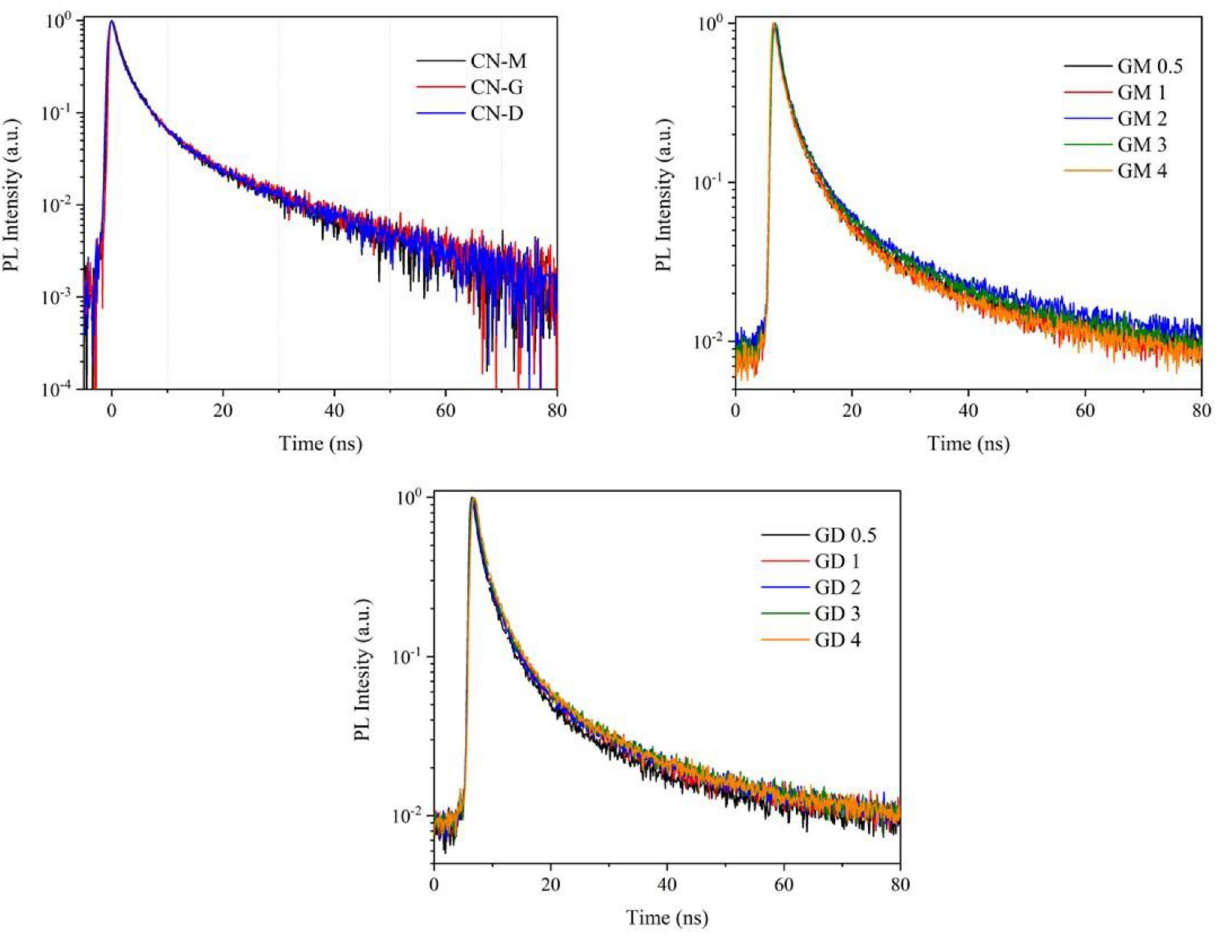
Figure 8. PL decay curves of CN